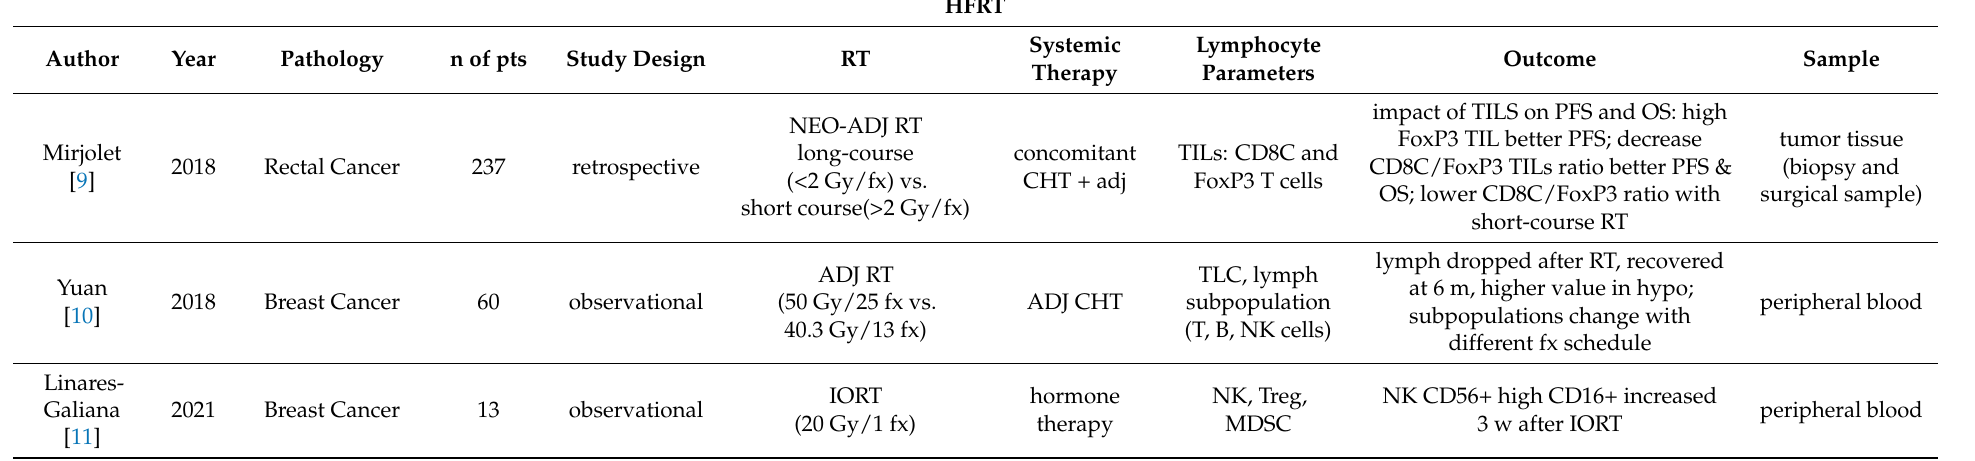
Table 1. Hypofractionated radiotherapy studies.